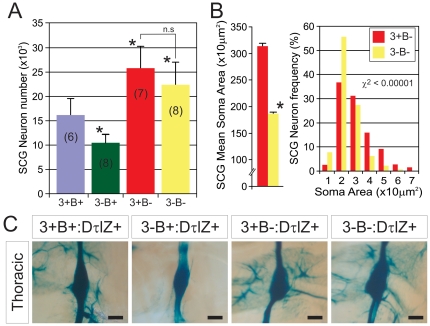
Target tissue innervation abnormalities in the absence of sympathetic neuron death in Egr3-deficient mice.(A) In the absence of the pro-apoptotic molecule Bax, sympathetic neurons in the SCG were protected from both physiologic and Egr3-dependent death. Approximately 1/3 of SCG neurons were lost in Egr3-deficient (3-B+) compared to wild type (3+B+) mice. In the absence of Bax, physiologic sympathetic neuron death (3+B−) and Egr3-dependent neuron death (3-B−) was inhibited. Inhibition of physiologic death increased the total number of SCG neurons as previously reported [10]. (number of SCG analyzed from 8–12 week old mice indicated in parentheses; *  =  p<0.01 and n.s. =  non-significant compared to 3+B+ mice, Student's t test) (B) In the absence of Egr3 and inhibited apoptosis (3-B−), SCG neurons were significantly atrophic. (8–12 week old mice analyzed, *  =  p<0.001 compared to 3+B−, Student's t test and size-frequency, χ2<0.0001). (C) Similar qualitative results were observed in thoracic prevertebral ganglia as apoptotic death was rescued in all sympathetic neurons. Compared to wild type ganglia (3+B+), 3-B+ ganglia were notably smaller and ganglia lacking Bax, with or without loss of Egr3 were larger. All mice were 8-12 weeks of age and expressed the DτlZ sympathetic reporter transgene to highlight the ganglia after LacZ histochemical staining (scale bar  =  25 µm).